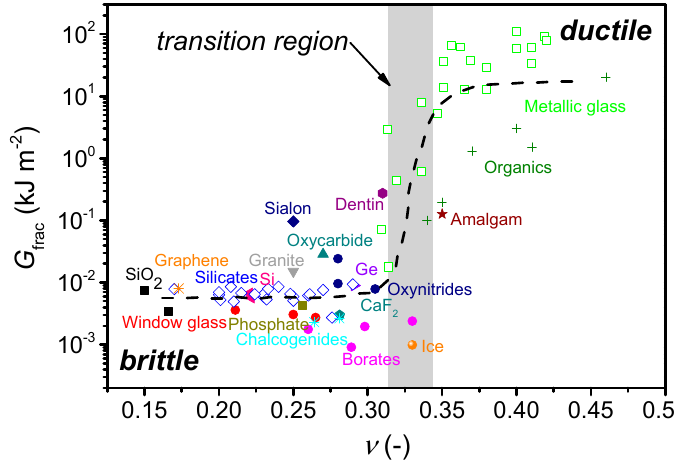
Figure 1. Dependence of fracture energy ( G frac ) on Poisson’s ratio ( ν ) for a range of materials, showing a brittle-to-ductile transition in the range of ν from 0.30 to 0.33. The figure is reproduced with the data from Lewandowski et al. [9] and Tian et al. [17]. We also extend it with new G frac data for silicate glasses [10,18–21], borate, chalcogenide, and metallic glasses [10,20], and graphene [22,23] obtained by single-edge pre-crack beam (SEPB), chevron notch (CN), single edge notch beam (SENB), indentation fracture (IF), or tensile testing methods. The error of ν and G frac is estimated to be 0.01 and 15%, respectively. The dashed line is a guide for the eye.